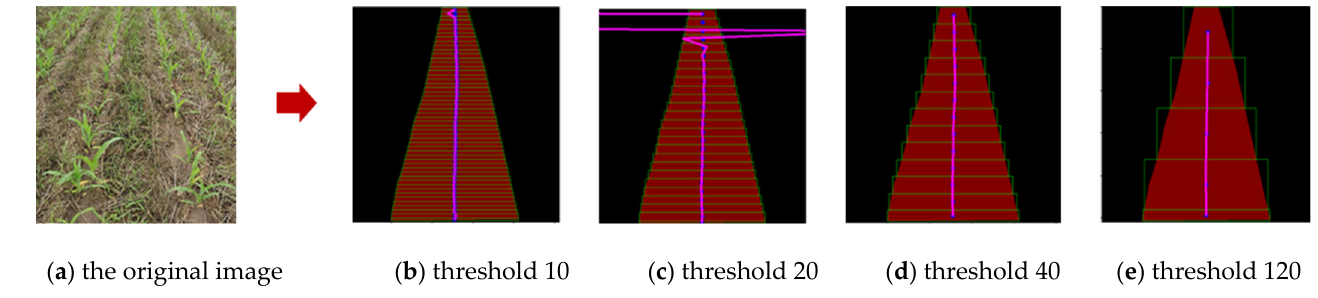
Figure 9. Incremental sub-ROI search analysis.